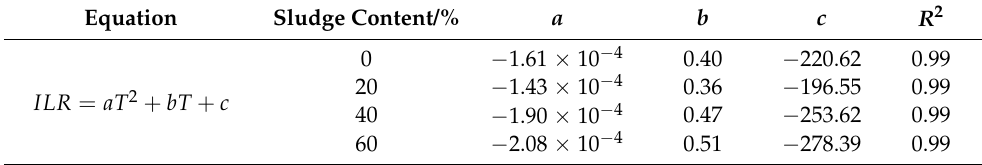
Figure 2. Ignition loss rate of ceramsite. Table 2. Fitting results of the relationship between ignition loss rate and